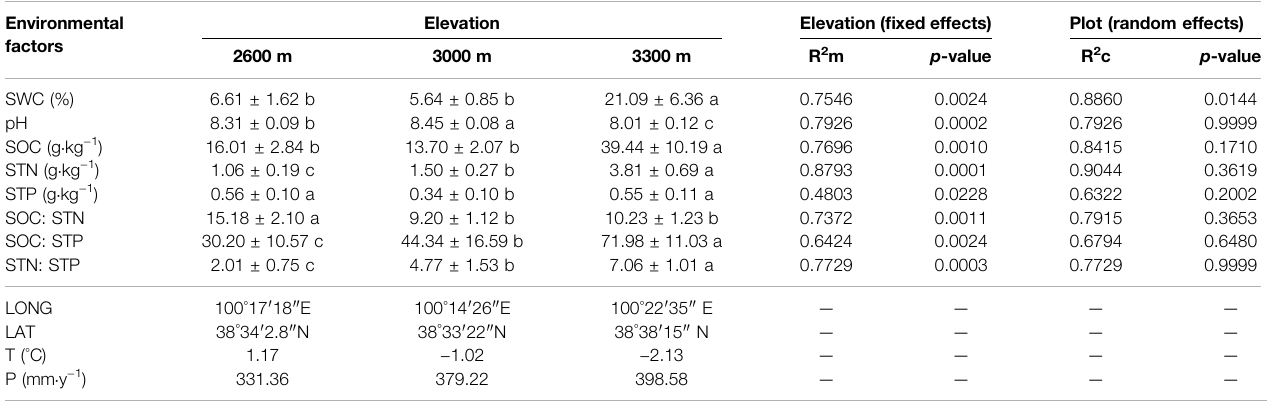
Row-wisenon-matchinglettersindicateasigni fi cantdifferenceamongelevationsat p ≤ 0.05level.pH:soilpH;SWC:soilwatercontent;SOC:soilorganiccarbonconcentration;STN:soil total nitrogenconcentration; STP:soil total phosphorusconcentration; LONG:longitude; LAT:latitude; R 2 m: the degree ofvariation ofthe variable interpretedfrom the fi xed effects; R 2 c: the degree of variation of the variable interpreted combination from the fi xed and random effects; T: temperature; P: precipitation; “—” : Test was not done.